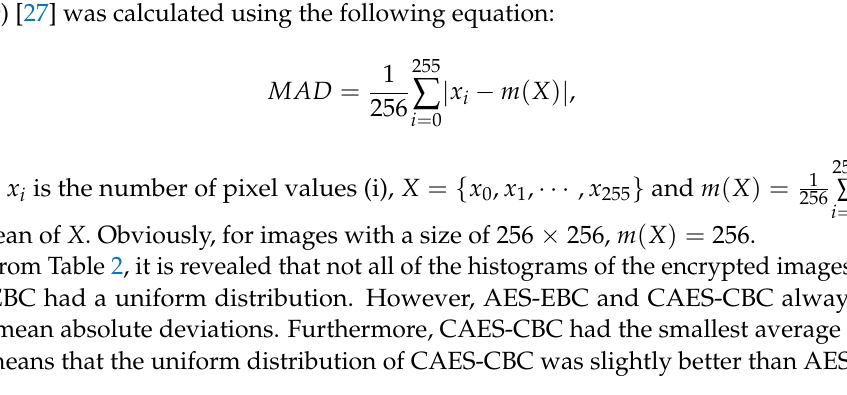
Figure 11. The visual effect and histograms of the plain and cipher images.